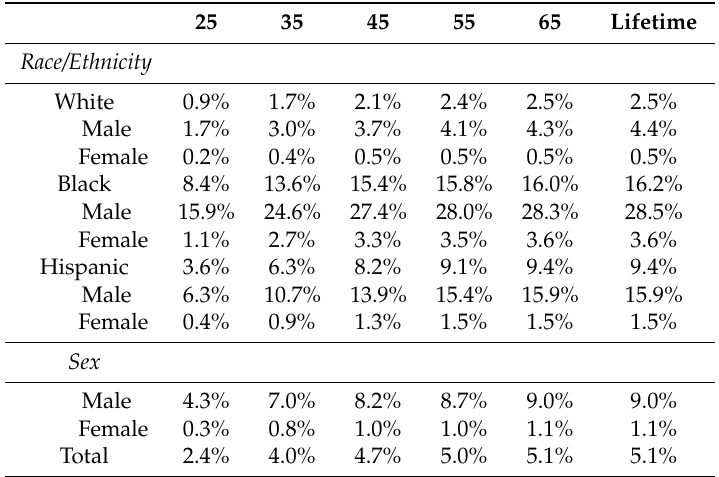
Table 2. Lifetime percentage likelihood of going to US state or federal prison, by sex, race, and age. Reproduced from Lifetime Likelihood of Going to State or Federal Prison